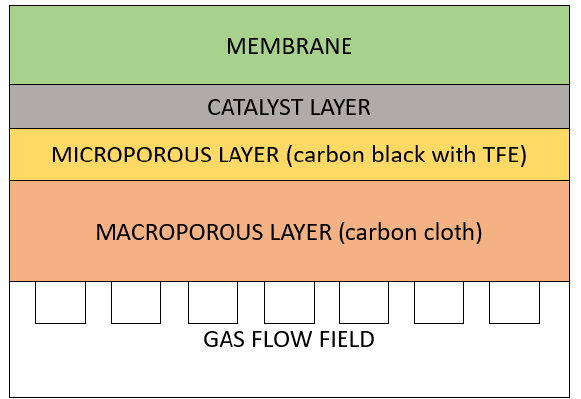
Figure 4. Scenario A structure of the membrane electrode assemblies (MEA) focusing on the gas diffusion layer (GDL) components.